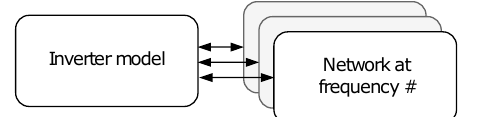
Figure 2. Separate computation of nonlinear inverter model from the network that is split by shifting